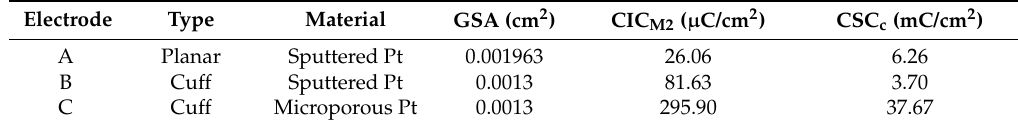
Table 4. Results for the three electrodes of this study.